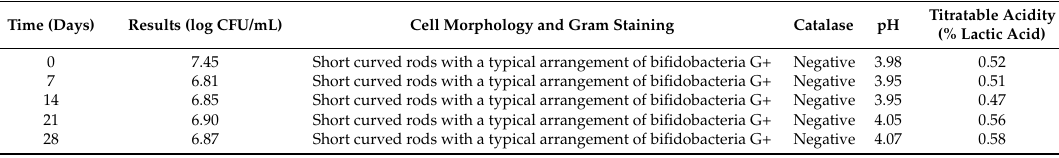
Table 3. Enumeration of B. animalis subsp . lactis Bb-12 and determination of pH and titratable acidity of probiotic functional carbonated beverage immediately after manufacture and during refrigerated